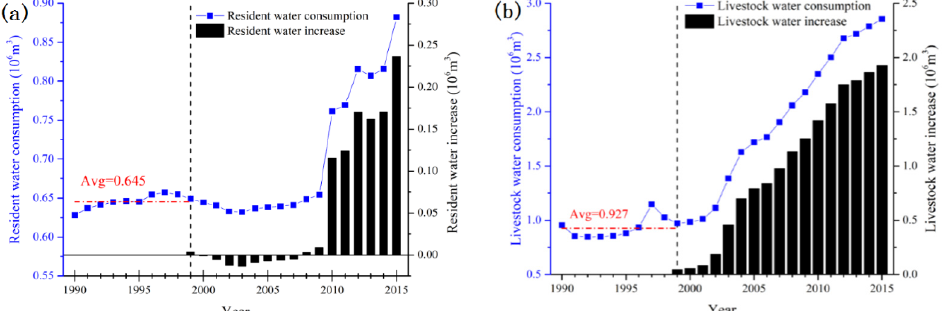
Figure 12. The variations of ( a ) residential water consumption and ( b ) livestock water consumption within the HN basin from 1990 to 2015.